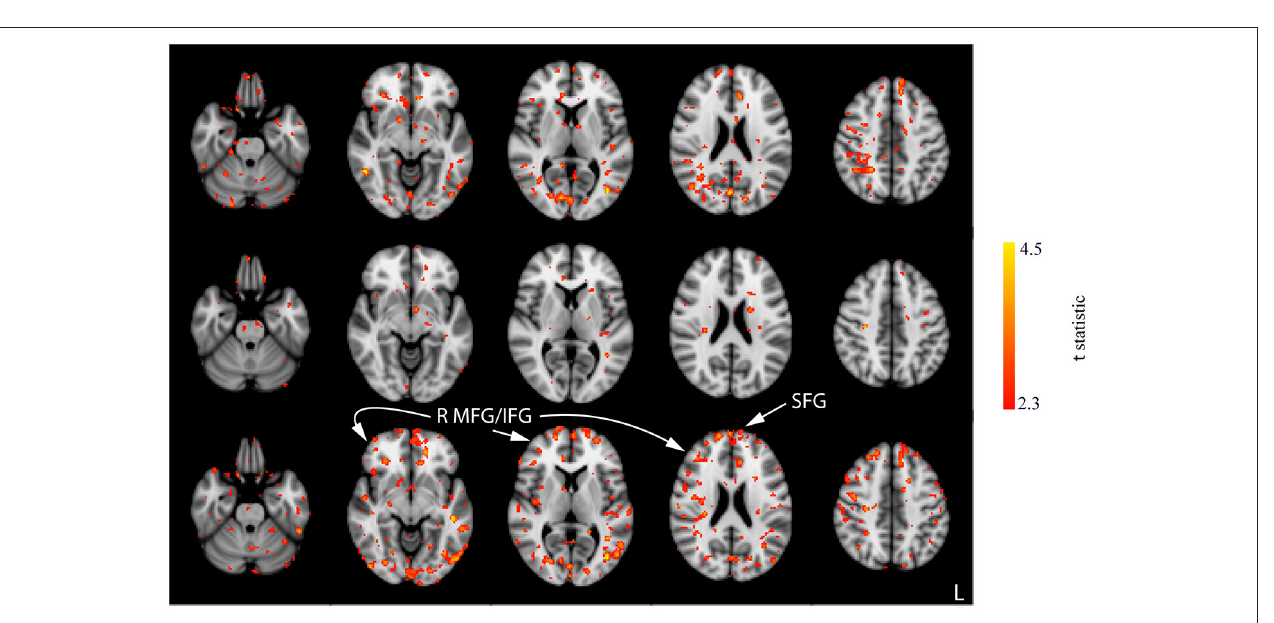
FIGURE 4 | Results of the unpaired t- tests between CON and ACT 1mA for the change between session 1 pre-stimulation and session 1 post-stimulation (top row), session 2 post-stimulation (middle row), and session 3 post-stimulation (bottom row). Axial slices are taken from MNI coordinates z = − 26, − 8, 6, 22, and 44mm (left to